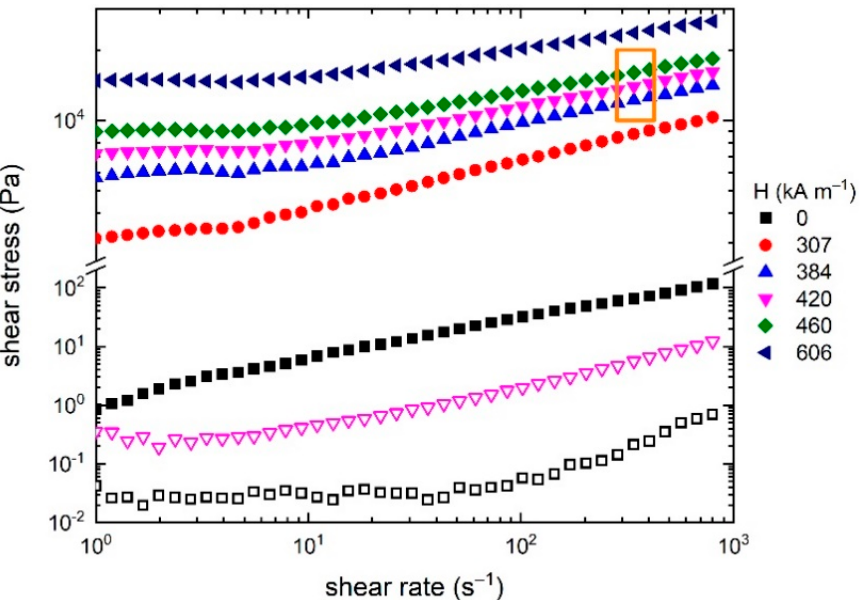
Figure 2. Flow curves at various magnetic field intensity; processing window marked in orange. Full symbols: MR slurry; empty symbols: carrier liquid (ferrofluid)